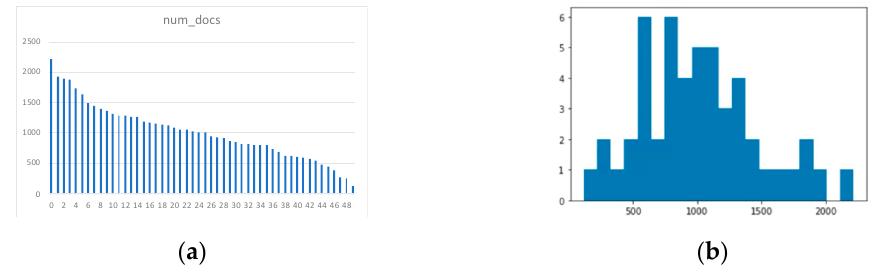
Figure 4. Results of topic modeling: ( a ) distribution over number of documents per topic; ( b ) histogram of number of documents per topic. As can be seen from ( a ), we named each topic in descending order of number of documents. That is, topic 0 has the highest number of documents. Detailed description of each topic is provided in Table A2.